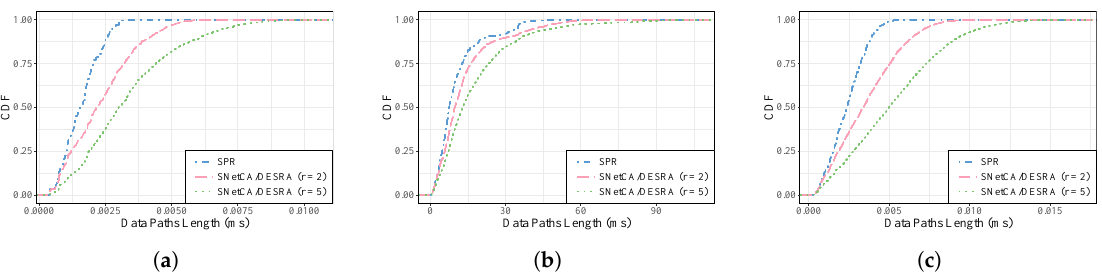
Figure 11. Cumulative distribution function of data paths latency for one controller under delay constraint in the: ( a ) New York topology; ( b ) Geant topology; and ( c ) Norway topology.